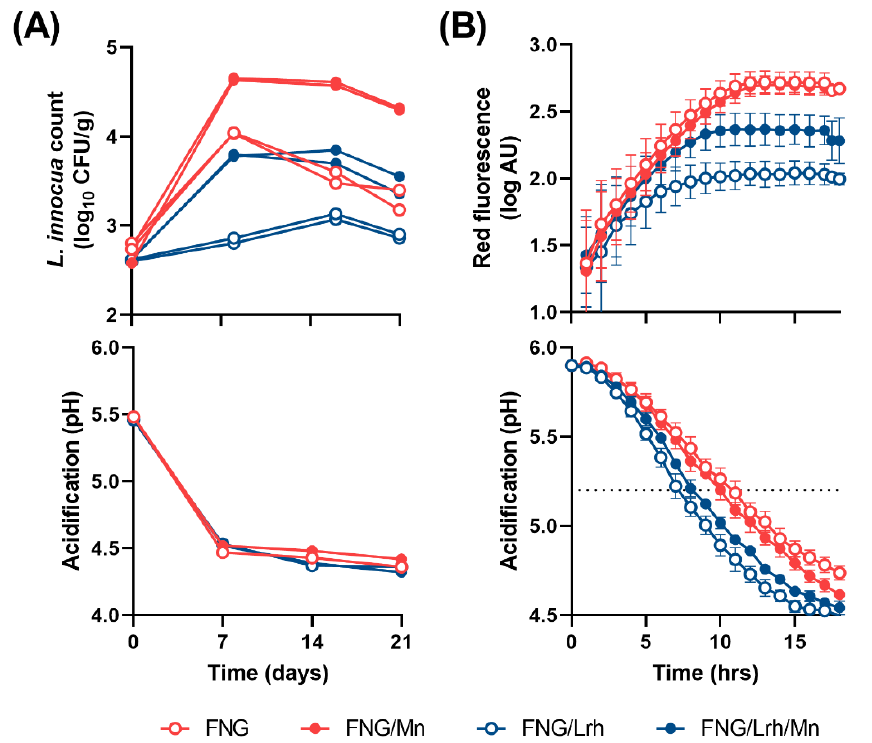
Figure 3. Growth of L. innocua and development of pH in cottage cheese models. ( A ) Progression of L. innocua counts in CCM prepared from milk fermented with FNG +/ − Lrh-FQ +/ − 6 mg/L MnCl 2 (top panel) and the corresponding acidification profile (bottom panel). ( B ) Development of red fluorescence by RFP-tagged L. innocua after inoculation in pH-adjusted CBM +/ − 6 mg/L MnCl 2 during incubation at 30 °C (top panel) and acidification profiles of non-contaminated CBM samples under similar conditions (bottom panel). Red fluorescence was normalized using fluorescence values measured at timepoint 0, whereas acidification curves were normalized to start at pH 5.8 after converting the hue of indicator dye to pH.